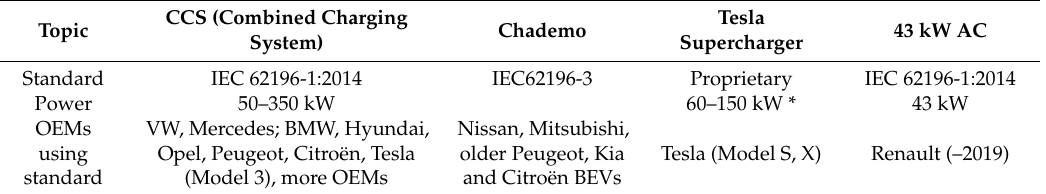
Table 1. Fast charger